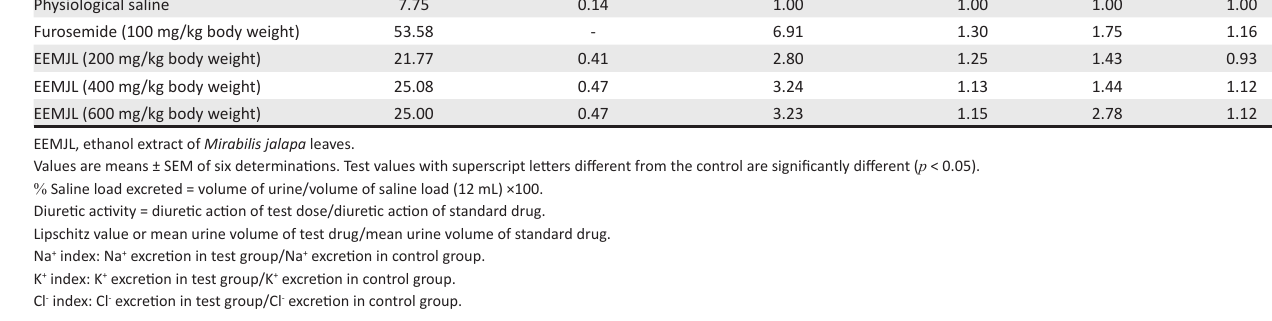
TABLE 4: Other computed urinary indices of male rats administered ethanolic extract of Mirabilis jalapa leaf. Treatments % Saline load excreted Lipschitz value Diuretic index/Diuretic action Na + index K + index Cl - index Physiological saline Furosemide (100 mg/kg body